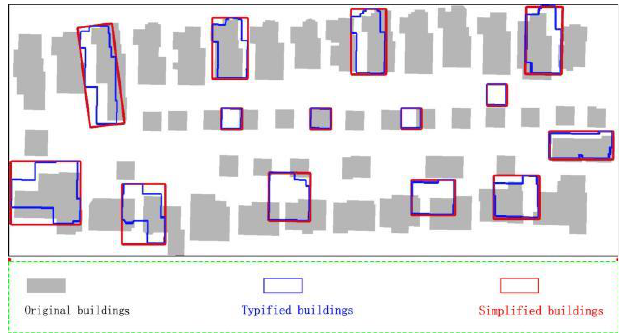
Figure 10. Simplification of the building shapes.